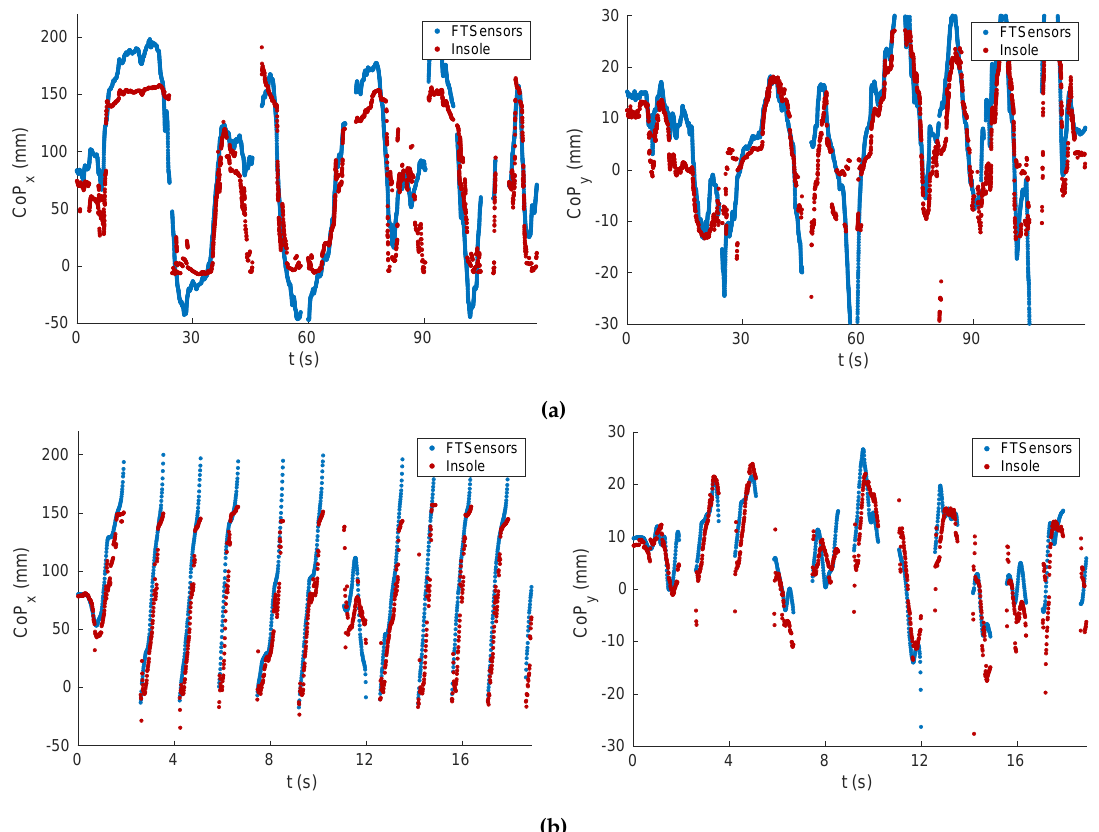
Figure 11. Center of pressure (CoP) tracking. ( a ) Task T3. ( b ) Task